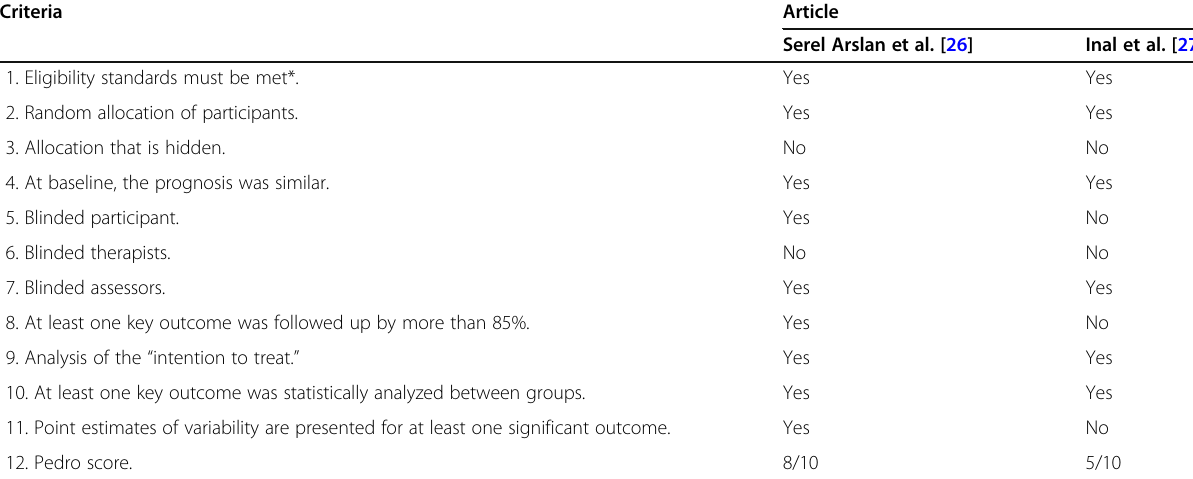
Table 3 Critical appraisal by PEDro scale Criteria